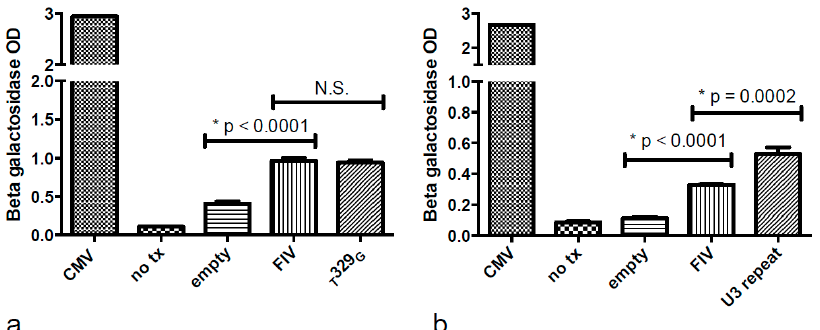
Figure 7. Point mutation T 329 G results in no change, while the U3 insertional repeat in the FIV-C promoter results in augmentation of promoter function in an in vitro reporter assay. The promoter of the inoculating virus and the promoter with the T 329 G SNP demonstrate strong basal promoter function in human 293T cells relative to negative controls (no transfection and a promoterless β -galactosidase plasmid-“no tx” and “empty”, respectively). The promoter function with the common T 329 G SNP was not significantly (N.S.) different from the wild type inoculating FIV promoter ( a ); Cells transfected with the proviral U3 direct repeat mutant demonstrated a basal promoter function significantly above the wild type inoculating FIV promoter ( b ). Cells transfected with a CMV- β galactosidase plasmid (CMV) served as a positive control. An asterisk denotes statistical significance for selected pairwise comparisons (* p < 0.05) and error bars denote standard deviation.